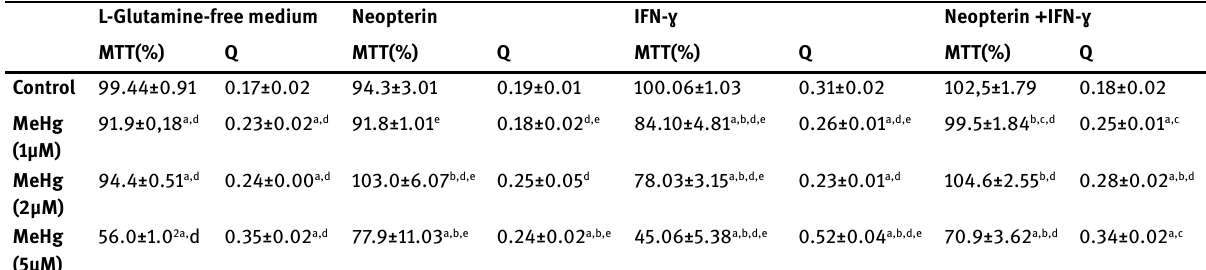
Tables 3: Total mitochondrial metabolic activity and oxidative stress coefficient of MeHg-exposed SH-SY5Y human neuroblastoma cell line in glutamine-free medium at the end of the 24-hour period. ( IFN- ɣ : Interferon-gamma; MeHg: Methyl mecury; MTT: Cell viability; Q: [(NOx/Cc )/ (MTT/Cc)], oxidative stress coefficient